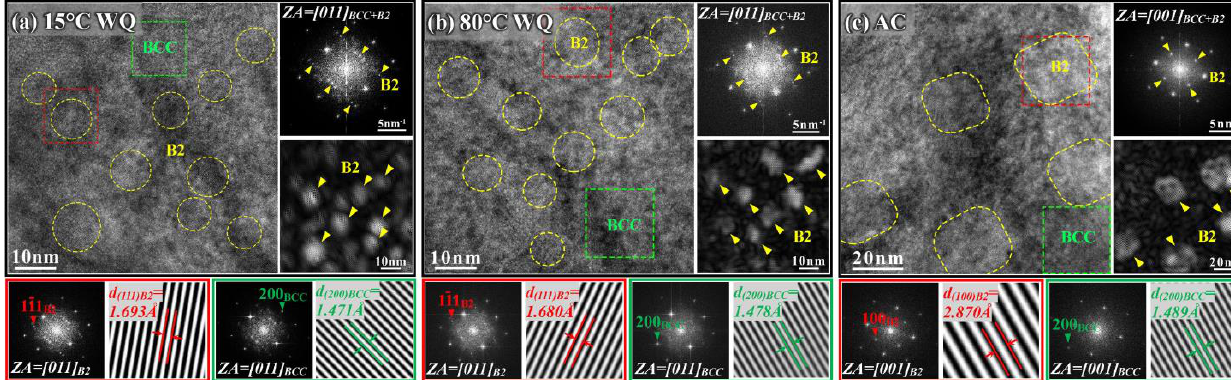
Figure 5. HRTEM images, FFT images and FFT filtered images for the solution-treated 6Ni2Mo alloy subjected to 15 °C WQ ( a ), 80 °C WQ ( b ) or AC ( c ). Note that the results in the red and green solid box were from the corresponding red and green dashed areas in the HRTEM images, respectively.